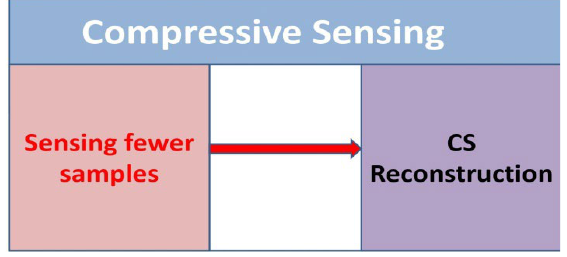
Figure 2. The CS compression scheme.